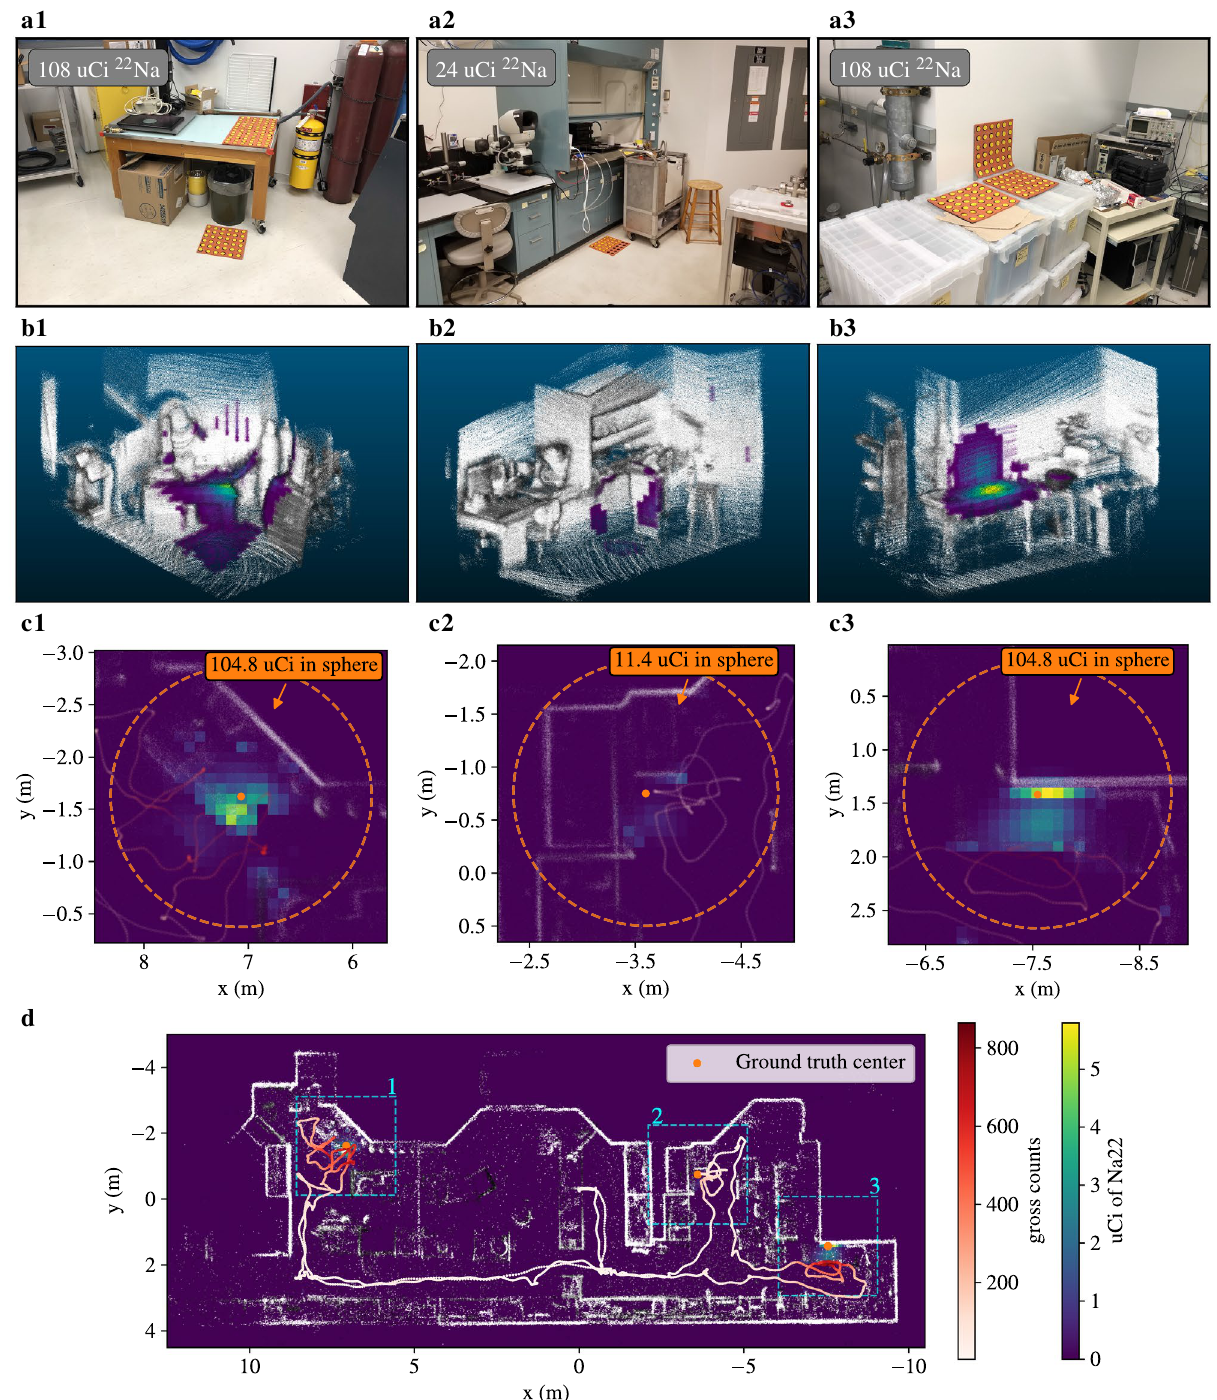
Figure 3. Distributed source reconstruction results. ( a ) Setup of the three distributed source distributions placed in a cluttered laboratory environment. ( b ) Cropped renderings of the 3D point clouds at the location of the three source distributions in ( a ), colorized by the quantified Compton MAP-EM reconstruction results with the bottom 1% of the reconstructed activity clipped to increase contrast with the point cloud. ( c ) Top-down projections of the reconstruction in the three source areas, with a 1.25 m sphere (in orange) around the center of the ground-truth sources to determine the reconstructed source activity. ( d ) Full top-down projection of the reconstruction